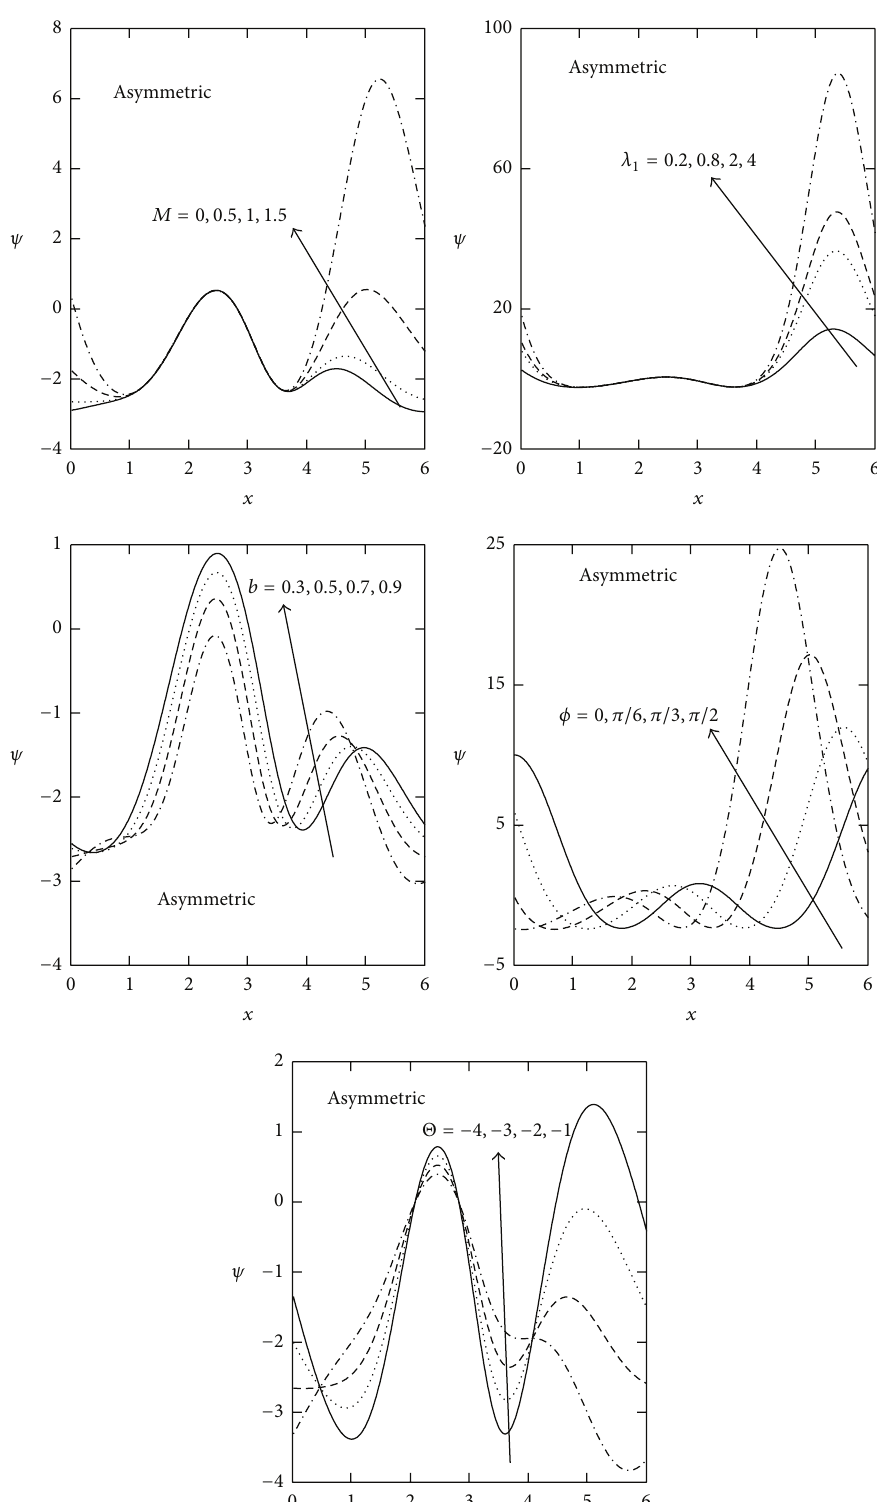
Figure 5: Variation of 𝜓 with influence of 𝑀 , 𝜆 1 , 𝑏 , 𝜙 , and Θ with respect to 𝑥